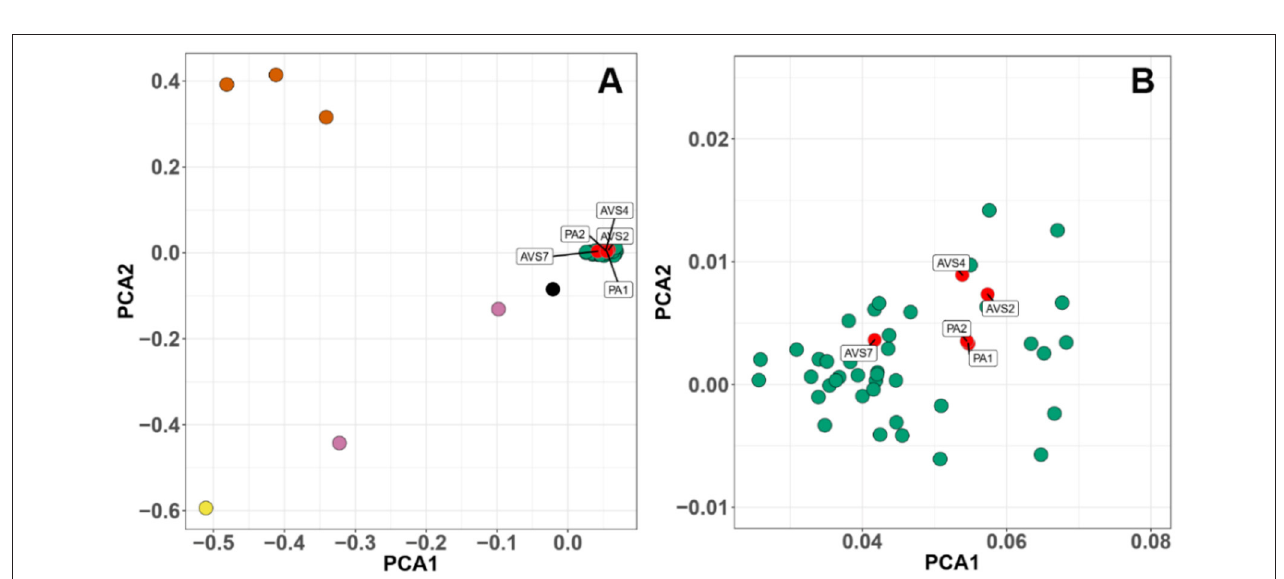
FIGURE 4 | Principal components analysis (PCA) of 3,900 SNPs in linkage equilibrium of a global panel of 54 Batrachochytrium dendrobatidis (Bd) isolates. Each point represents an isolate, colored by phylogenetic lineage. (A) Bd isolates separate into clearly defined clusters. (B) Higher resolution of the global panzootic lineage of Bd (BdGPL) cluster showing the position of the Chilean isolates within the cluster. The axes plot the first and second principal components, PCA1 and PCA2. Chilean isolates are clustered within BdGPL. Chilean isolates (red), other BdGPL (green), BdASIA2/BdBRAZIL (pink), hybrids between the previous two groups (black), BdCH (yellow), BdCAPE